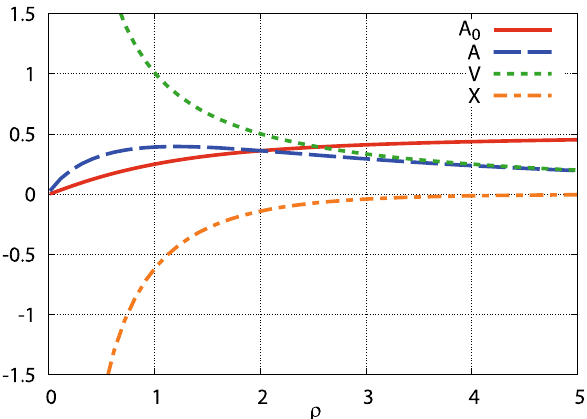
Fig. 2 The fields of A 0 , A , V , and X as functions of ρ = g v r at a ∞ = 0 . 5. Here A ( x ) = V ( x ) + X ( x ) where V ( x ) agrees with the Wu–Yang monopole and X ( x ) corresponds to the massive mode. The time component A 0 ( x ) is finite by itself